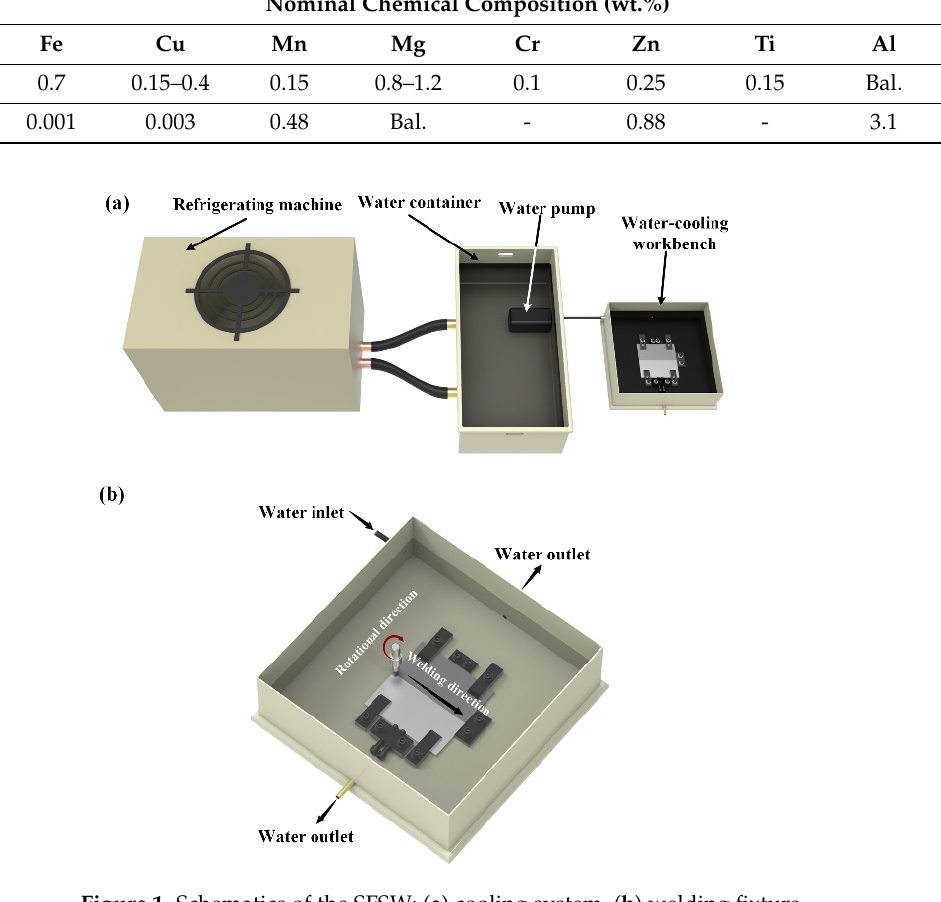
Figure 1. Schematics of the SFSW: ( a ) cooling system, ( b ) welding fixture.